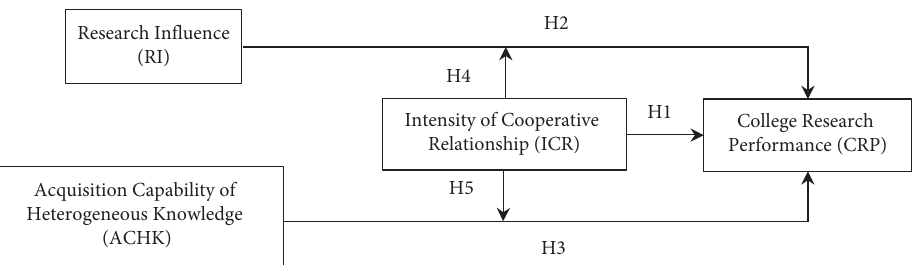
Figure 1: Research